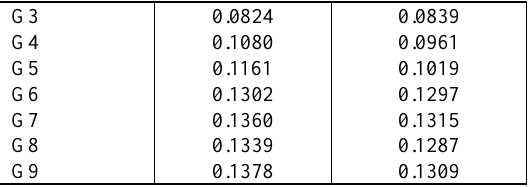
Table 2. Comparison of the standard deviation of the frequency error between VTL and STL